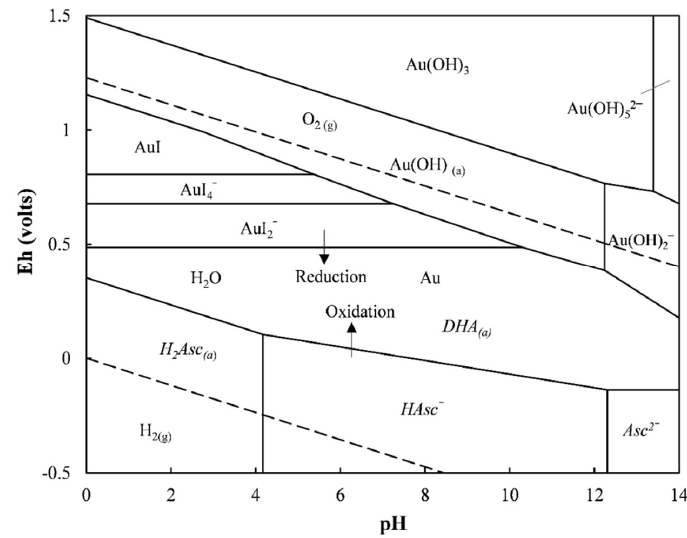
Figure 12. The Eh–pH diagram of gold–iodide and ascorbic acid species in the solution. (Condition: [Au] = 32.3 mg/L, [I] = 0.072 M (72 mM), Eh = −0.5–1.5 volts, P = 1 atm at pH 0–14, 25 °C, (NBS, STABCAL software)).